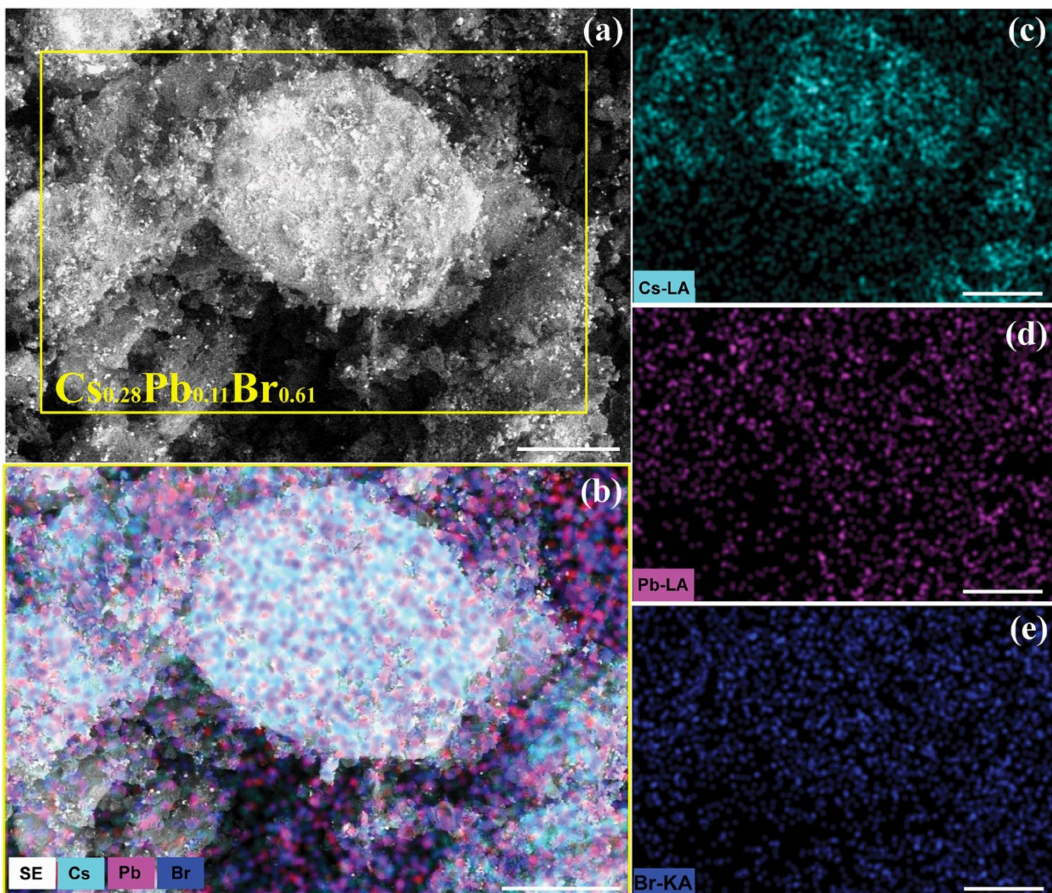
Figure 2. Morphological and elemental compositional characterization of Target (RT). ( a ) SEM micrograph image of a representative region of Target (RT). ( b ) Overlap of the SEM image pointed out by a yellow rectangle in panel ( a ) and the corresponding Cs, Pb and Br EDS maps reported in panels ( c ) for Cs, ( d ) for Pb, and ( e ) for Br elements. (Scale bars ( a – e ): 200 µ